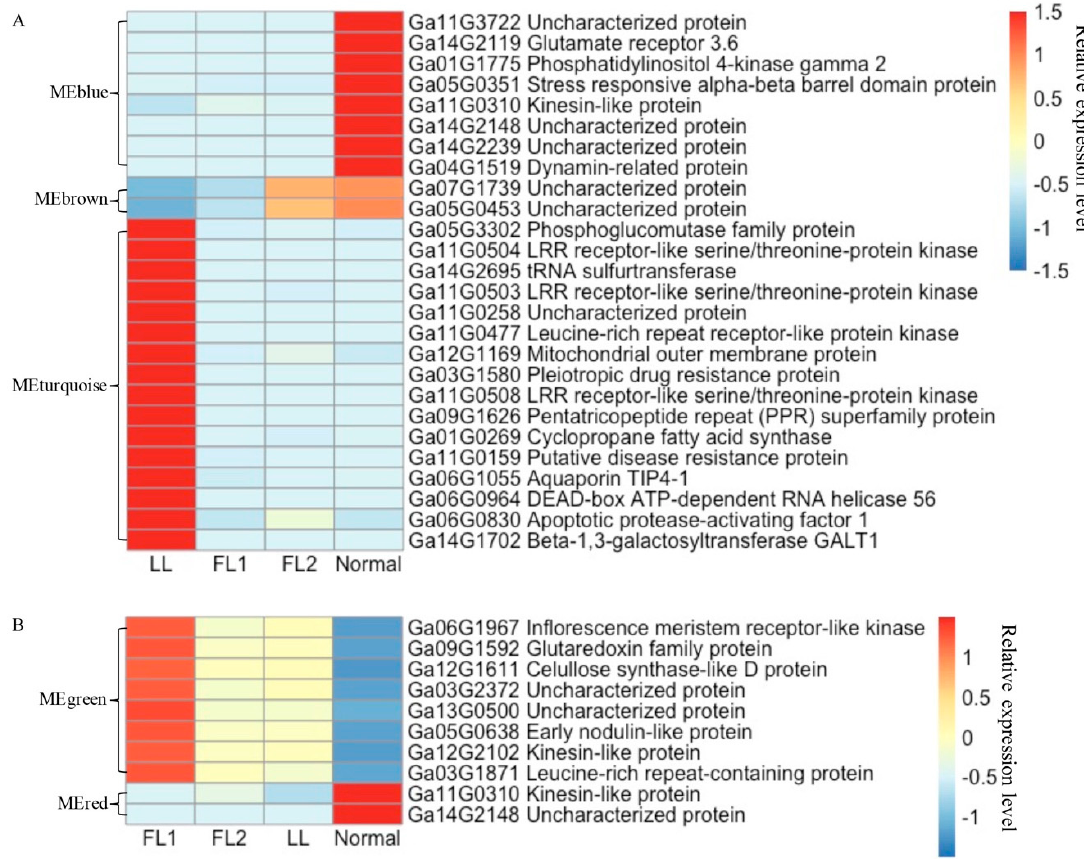
Figure 9. Relative expression heatmap of hub genes detected by weighted gene co-expression analysis (WGCNA). ( A ) Expression heatmap and description of hubs genes associated with lint fibre initiation. ( B ) Expression heatmap and description of hubs genes associated with fuzz development.